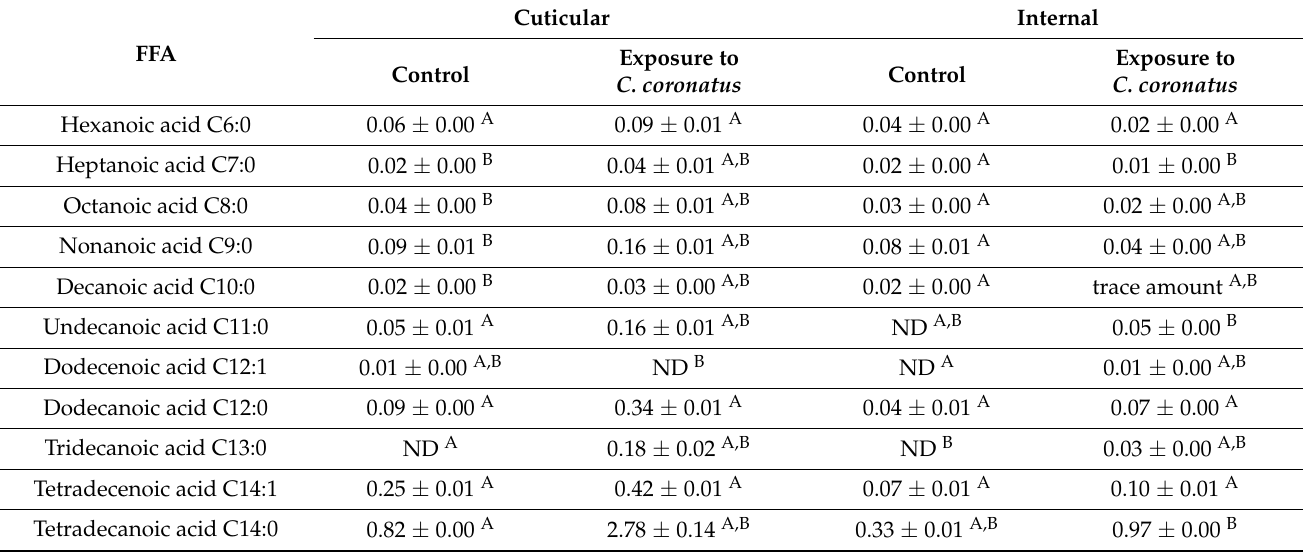
Table 5. Fatty acid content of the cuticular and internal lipids extracted from Sarcophaga argyrostoma adults ( µ g/g of insect body ± SD). Cuticular Internal FFA Exposure to Control C. coronatus Control